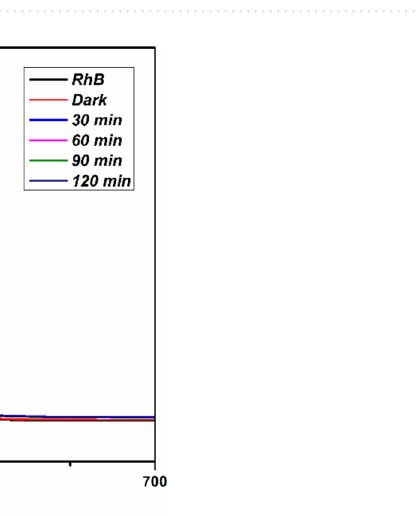
Figure 5. UV–Visible spectra for the disintegration of RhB dye by ( a ) CaO, ( b ) CaTiO 3 , ( c ) MgO, and ( d ) MgTiO